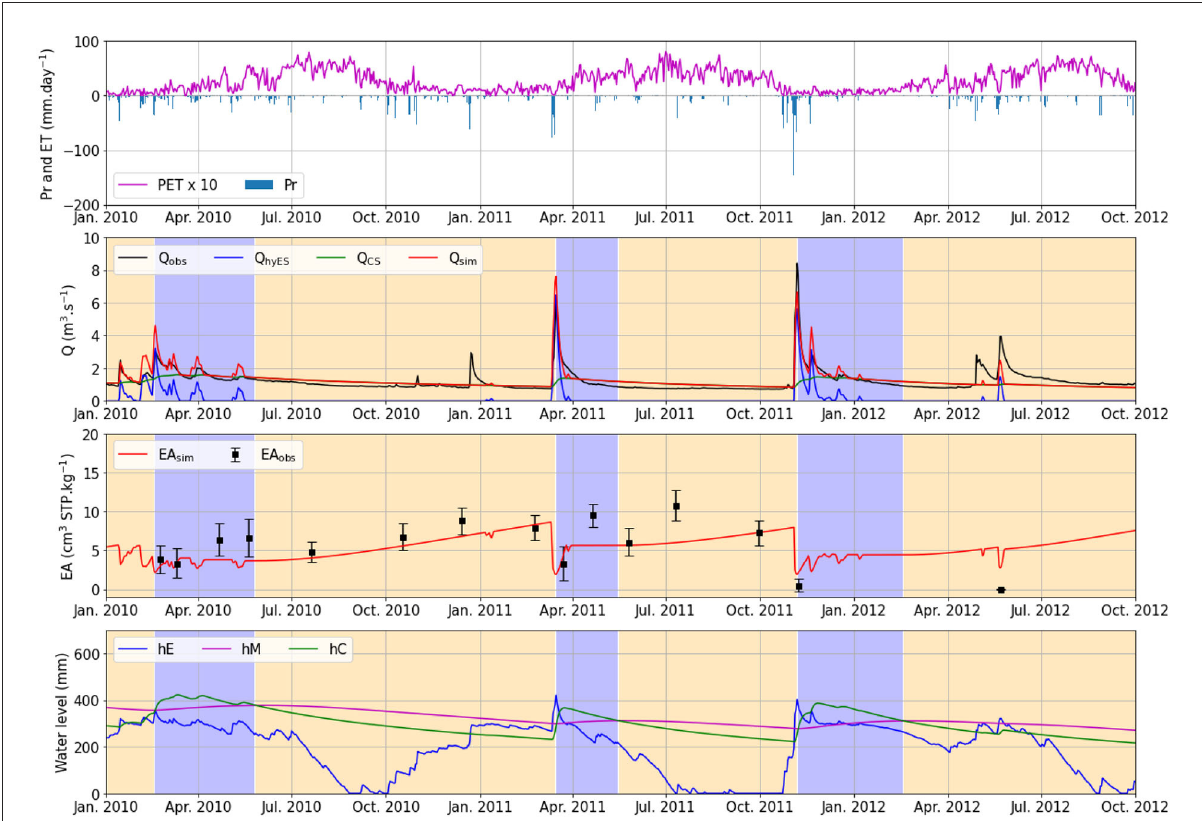
FIGURE5 (i) Precipitation and potential evapotranspiration time series, (ii) observed and simulated spring discharges, (iii) observed and simulated spring EA time series, (iv) water level time series in the compartments E, M, and C. Periods with blue background color correspond to periods when the water level in C is greater than the water level in M so Q MC > 0 (compartment C feeds the compartment M). Conversely, periods in orange background color correspond to periods when compartment M feed compartment